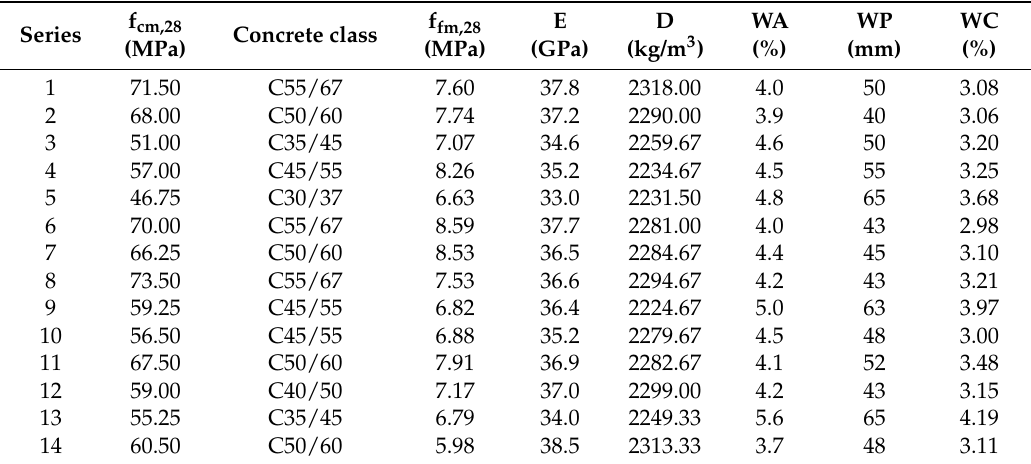
Table 9. The average results of concrete properties tests for individual experimental series and for control